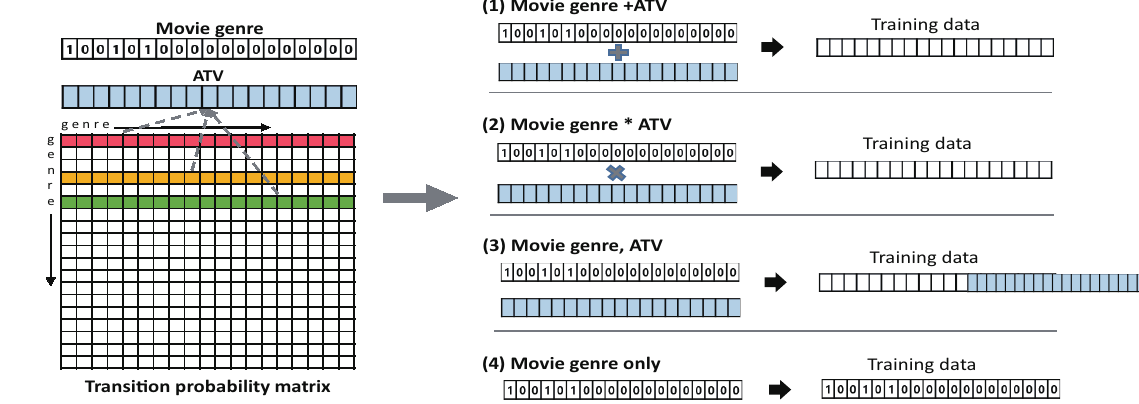
Figure 6. Four types of training